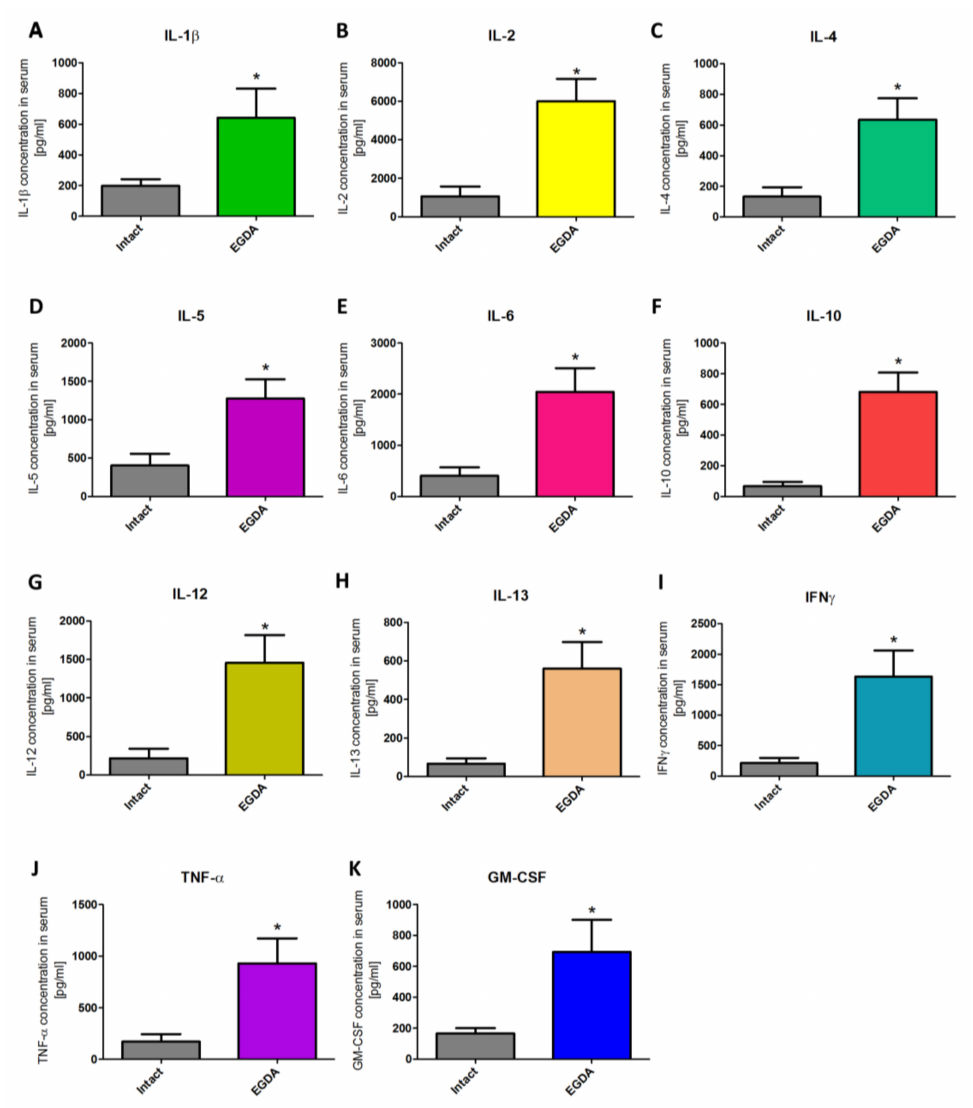
Figure 8. Serum concentration of interleukin (IL)-1 β ( A ), IL-2 ( B ), IL-4 ( C ), IL-5 ( D ), IL-6 ( E ), IL-10 ( F ), IL-12 ( G ), IL-13 ( H ), interferon (IFN)- γ ( I ), tumor necrosis factor (TNF)- α ( J ), and granulocyte-macrophage colony-stimulating factor GM-CSF ( K ) in rats without (intact) and with esophagogastroduodenal anastomosis (EGDA). Results are mean ± SEM of five samples per each experimental group. Asterisk (*) indicates a significant change as compared with respective values obtained in rats without EGDA ( p <